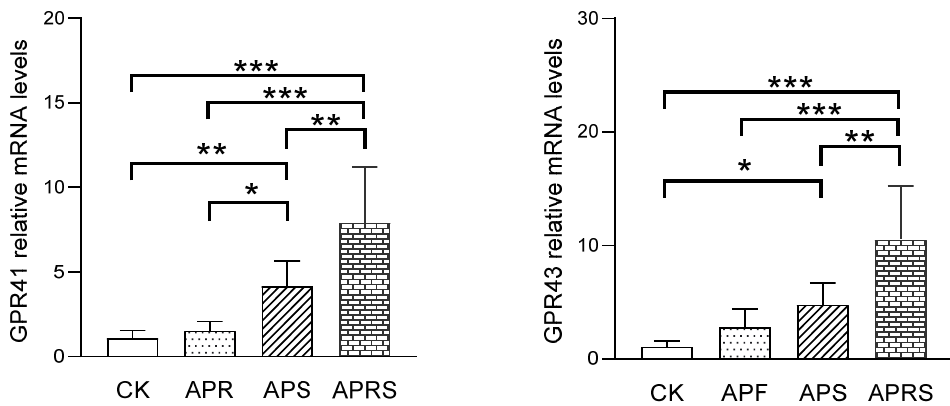
Figure 7. The relative mRNA expression of SCFA receptors in jejunum tissue of aged mice (* p